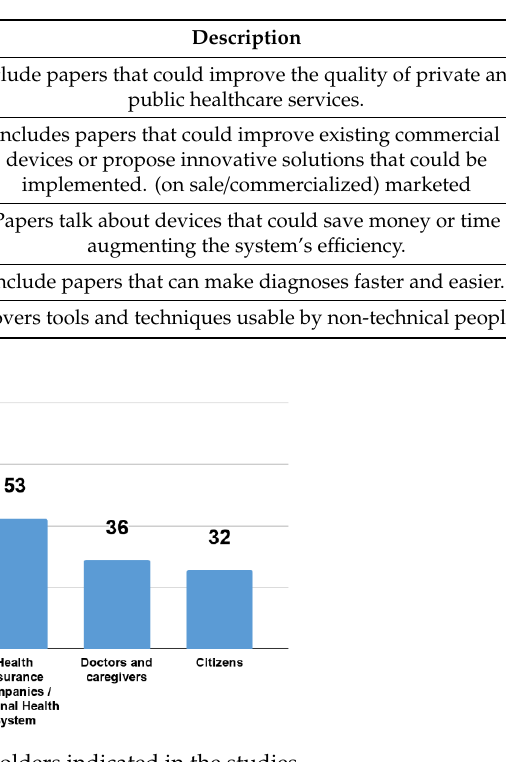
Table 4. Device types’ definitions.